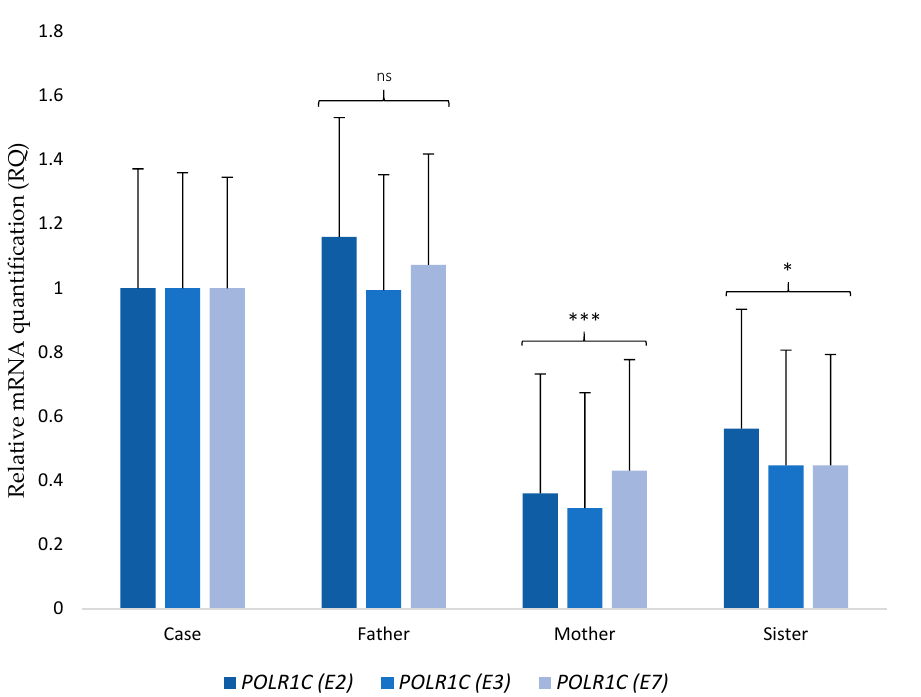
Figure 3. RT–PCR analysis of mRNA expressions of POLR1C in the patient and her unaffected family members. mRNA expression determined by RT–PCR is calculated as a ratio relative to HPRT1 and expressed relative to her parents and sibling. (E2), (E3), and (E7) indicate the different primers used to analyze expression of POLR1C . Error bars represent standard deviation (SD). ***, p < 0.0001; *, p < 0.05; ns, not significant.